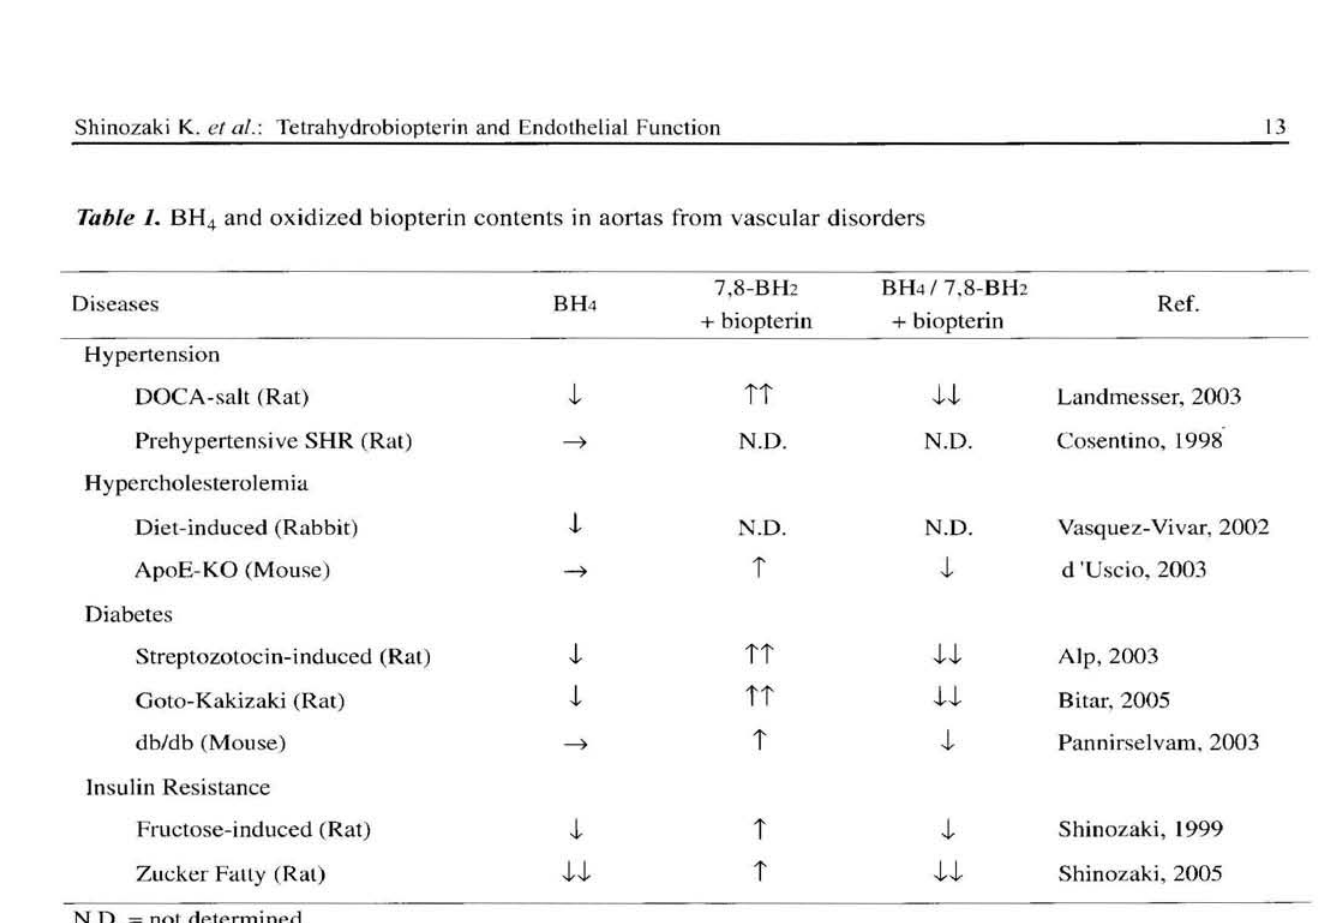
7,8-BH2 BH4/7,8-BH2 I- biopterin + biopterin